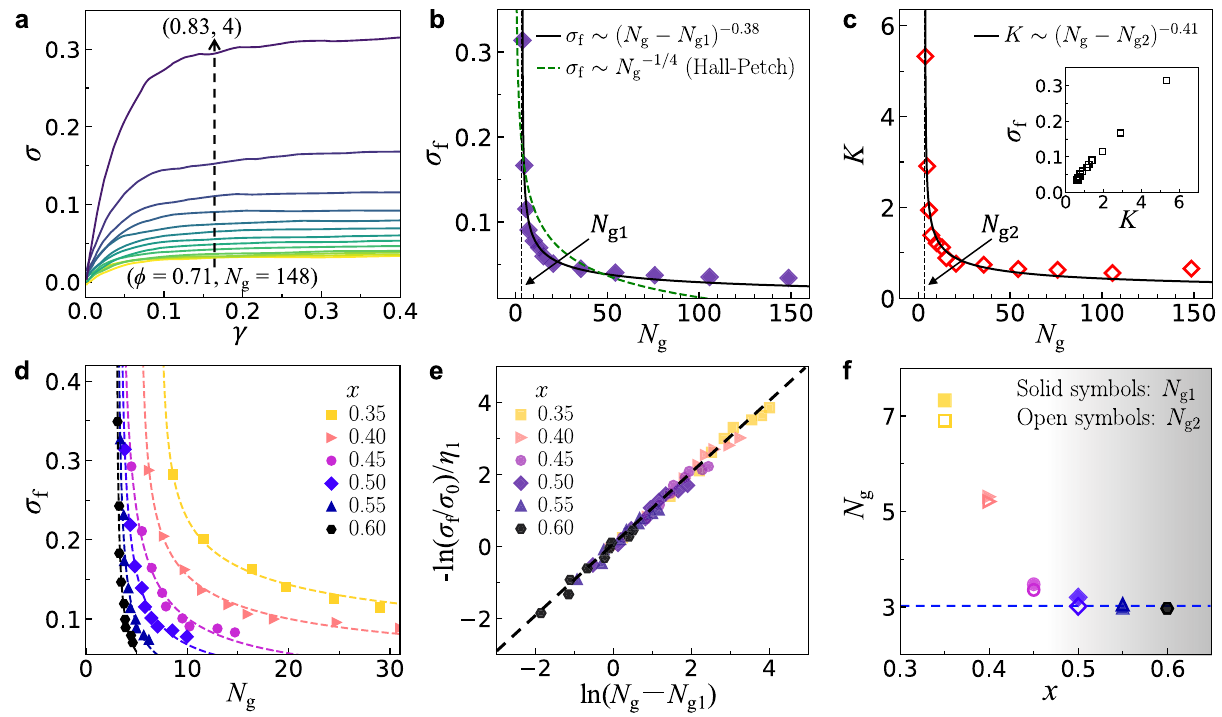
Fig. 3 Mechanical properties. a Stress – strain curves for glass-crystal composites (GCCs) with 50% soft particles at different packing fraction ϕ , corresponding to different grain size N g . b The fl ow stress σ f averaged over the strain range 0.3 < γ < 0.4 in ( a ). Black curve: the fi tting of Eq. (2) with N = 3.24 ± 0.17 (vertical dashed line) and η = 0.63 ± 0.09. The Hall – Petch relation (green-dashed curve) cannot well fi t the data. c The shear modulus K g1 1 measured from the slope of σ ( γ ) in the elastic regime of γ < 0.025 in ( a ). Black curve: the fi tting of Eq. (3) with N g2 = 3.07 ± 0.27 and η 2 = 0.72 ± 0.14. Inset: σ f ( K ). d σ f fi tted by Eq. (2) (dashed curves) at different x . e Rescaling of ( d ) collapses all the data on a straight line. f The fi tted minimum grain sizes from σ f ( N g ) (solid symbols) and K ( N g ) (open symbols) at different x (Fig. 3e). K ( N g ) at other mixing ratios also exhibit similar results as Fig. 3c. The minimum grain sizes N g1,2 fi tted from σ f ( N g ) and K ( N g ) are very close and can be reduced to three particles when the fraction of soft particles x ≥ 0.5 (Fig. 3f).